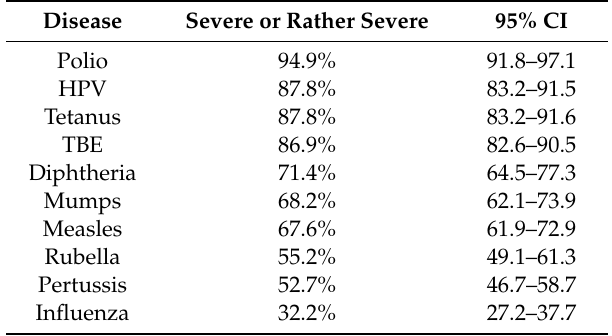
Table 2. Perception of the severity of di ff erent vaccine-preventable diseases by study